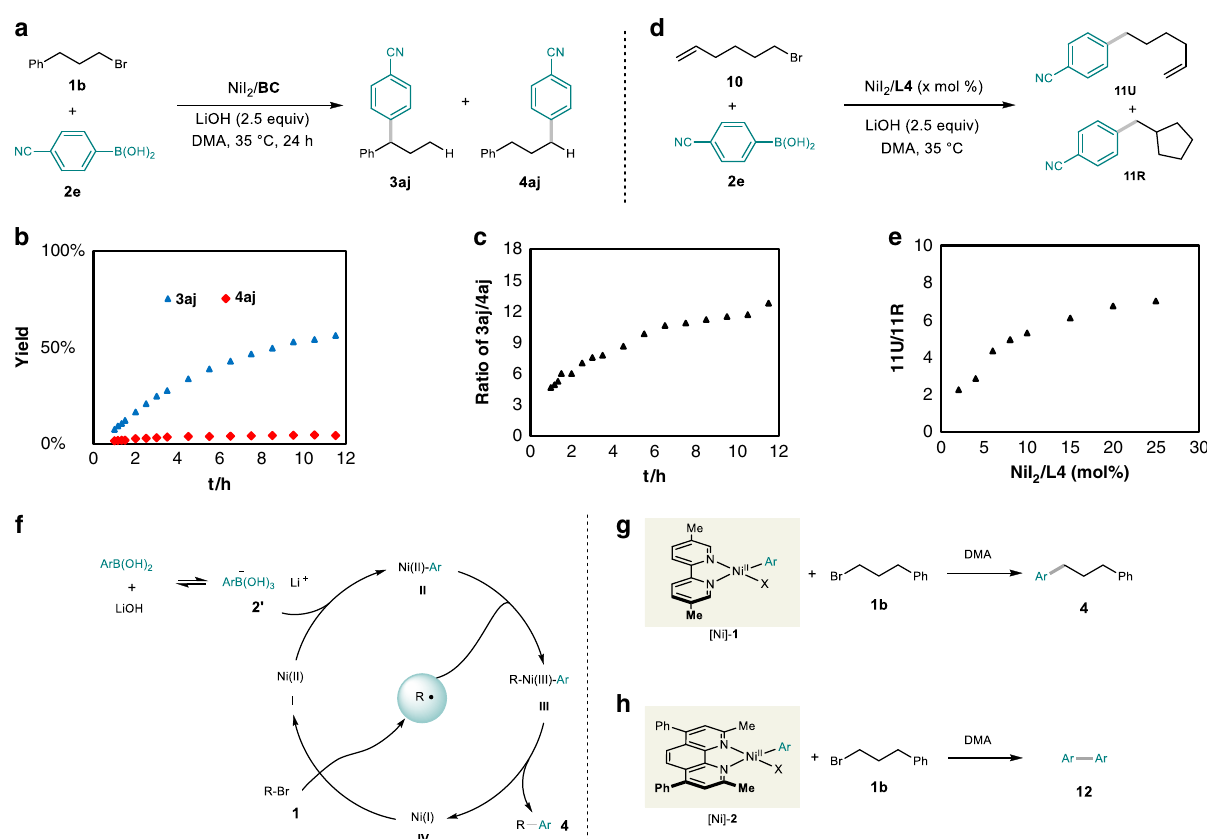
Fig. 9 The study of original-site products. a Model reaction. b Time course of product 3aj and 4aj . c Regioselectivity of migratory product with original- site product. d radical clock experiment. f Effect of catalyst loading on the ratio of 11U / 11R. f Proposed mechanism of original-site product. g Proposed process on reductive cross-coupling by Ni/ L4 . h Proposed process on reductive cross-coupling by Ni/ BC